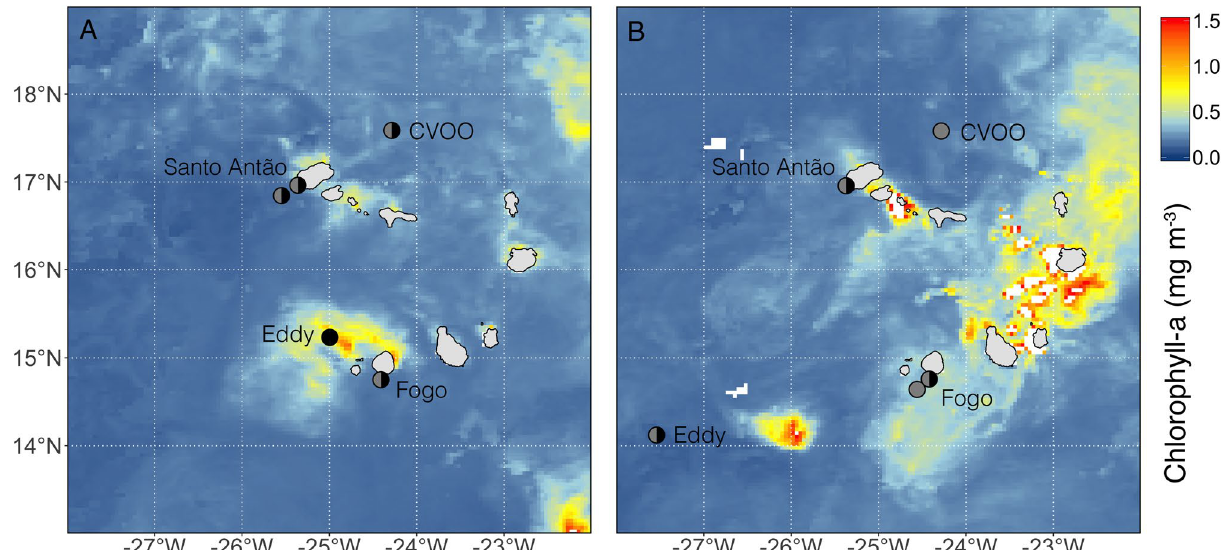
Figure 1. Sampling stations during the ( A ) POS520 cruise in 2018 and the ( B ) POS532 cruise in 2019, showing respective mean monthly chl-a concentrations (mg m −3 ) from the MODIS-aqua database 35 . Since cloud cover obstructed chl-a measurements in February for both years, monthly measurements are shown for March in 2018 and January in 2019. As a result, the MODIS-aqua data does not align with our cyclonic eddy sampling points. White fields indicate missing data due to cloud cover. Circles indicate day (grey) and night time (black)